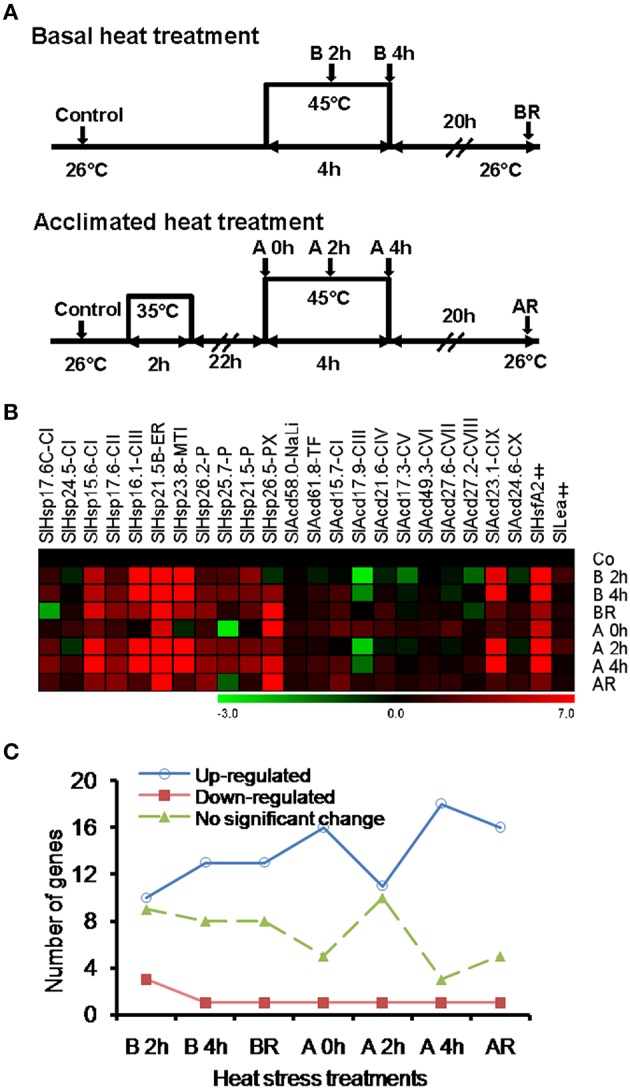
Heat treatment and gene expression analysis. (A) Diagrammatic representation of the heat treatment regimes. Shaded arrows represent sampling times and their designations. (B) Heat map of tomato Acd expression in response to different heat treatment regimes. (C) Graphical depiction of number of genes modulated by different heat treatment regimes. The expression levels of genes were calculated using the 2−ΔΔCt method and presented using fold change values transformed to log 2 relative to control. Transcriptional change values, as calculated by relative expression software tool (REST), along with details of ANOVA and standard error are shown in Supplementary Table 7A. Green and red colors indicate down- and up-regulation of the genes, respectively. Control (Co), basal 2h (B 2h), basal 4h (B 4h), basal recovery (BR), acclimated 0h (A 0h), acclimated 2h (A 2h), acclimated 4h (A 4h), acclimated recovery (AR). “‡” Symbol represents control genes obtained from previous publication (see Supplementary Table 1B for detailed information).